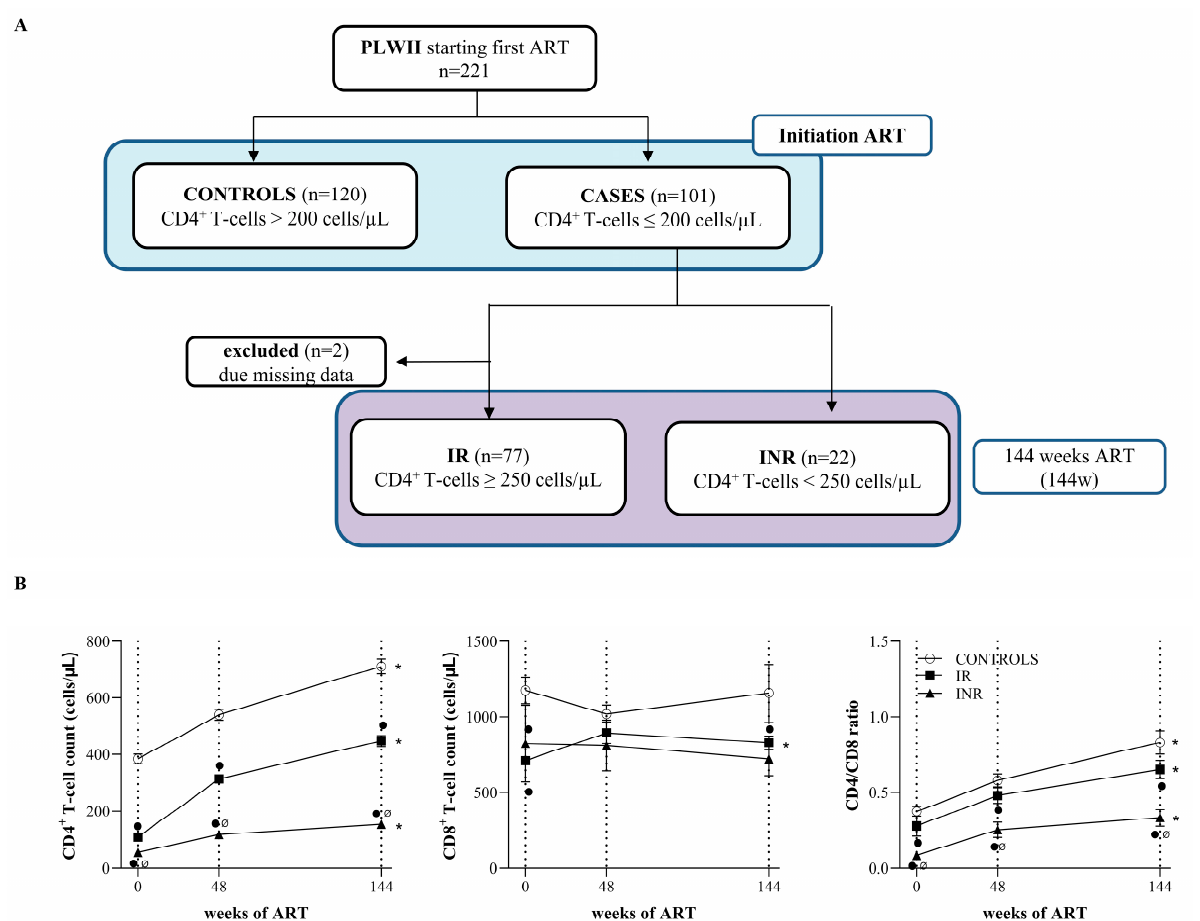
Figure 1. Study design. ( A ) Flow chart illustrating patient selection and enrolment. HIV-infected subjects were included and categorized as controls and cases according to the baseline ART threshold of 200 CD4 + T cell counts. Cases were categorized according to their immune status after 144 weeks of follow-up in “immunological recoverers” (IRs) or “immunological nonrecoverers” (INRs) depending on the threshold of CD4 + T cell counts of 250 CD4 + T cell counts/ µ L. ( B ) CD4 + T cell and CD8 + T cell count, and CD4/CD8 ratio in controls, IRs, and INRs during the study follow-up. * indicates significant differences at 144 w compared to baseline values using the Wilcoxon test. • indicates significant differences compared to controls, and Ø indicates significant differences between INRs and IRs at each point of time, by nonparametric Mann–Whitney test. PLHIV classified according to baseline CD4 + T cell counts as controls (baseline CD4 + T cell counts > 200 cells/ µ L) or cases (baseline CD4 + T cell counts ≤ 200 cells/ µ L). Cases were